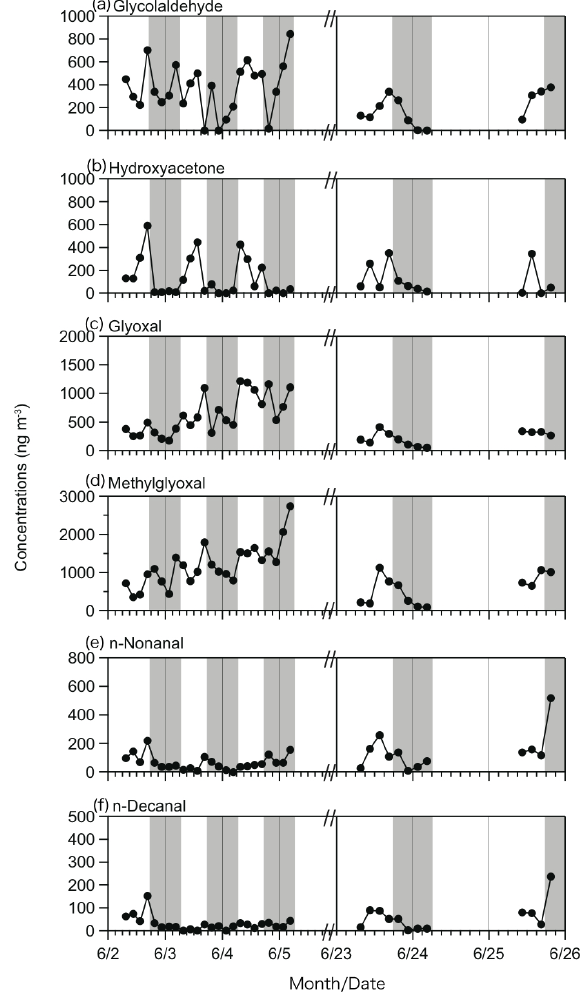
Fig. 4. Time-resolved variations of concentrations of gaseous car- bonyl compounds; (a) glycolaldehyde, (b) hydroxyacetone, (c) gly- oxal, (d) methylglyoxal, (e) n-nonanal and (f) n-decanal.